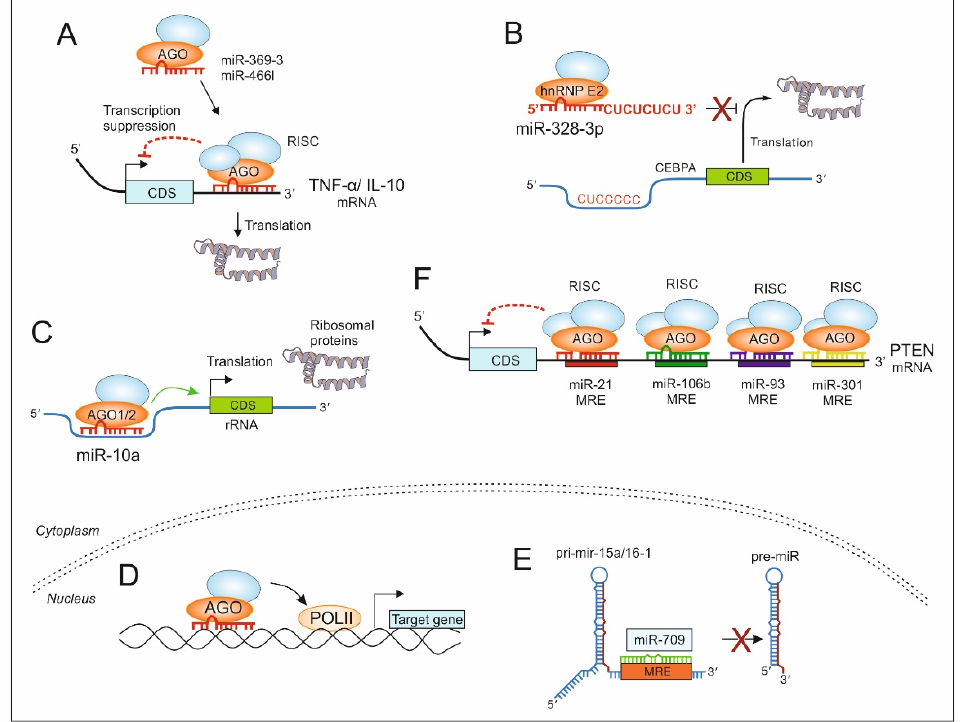
Figure 2. MiRs as regulators of signaling in the TME. The canonical function of miRs includes binding to 3' UTR of target mRNA to provoke post-transcriptional gene suppression either by decreasing the mRNA stability or decreasing translation ( A ). However, non-canonical functions include miRs that increase translation by binding to the 3 ′ UTR that masks the binding site of an RNA-binding protein that would otherwise induce mRNA degradation [78,79] (A). Increased translation can also be achieved by miR-328 by binding to the translation inhibitor heterogeneous ribonuclear protein E2 (hnRNP E2) in a seed sequence-independent manner that prevents and/or displaces CCAAT/enhancer-binding protein alpha (CEBPA) mRNA binding and rescues CEBPA mRNA translation [80] ( B ). Furthermore, miR-10a has been shown to bind the 5’ UTR of ribosomal protein mRNAs and to enhance their translation ( C ) [81]. MiRs also activate transcription either by recruiting transcription-activating factors to the complementary elements in gene promoters ( D ) [82,83] or by acting as a scaffold for transcription-regulating RNA [84]. MiRs can also regulate expression of its peer in the nucleus as in case of miR-709 that directly binds to a 19-nt MRE on pri-miR-15a/16-1 and blocks its processing into pre-miR-15a/16-1, thereby suppressing miR-15a/16-1 maturation ( E ) [65]. Target mRNA can be regulated by multiple miRs by targeting respective MRE in the 3’ UTR of e.g., PTEN, which can be targeted by miR-21, miR-106b, miR-93, and miR-301 ( F ) [85–89].